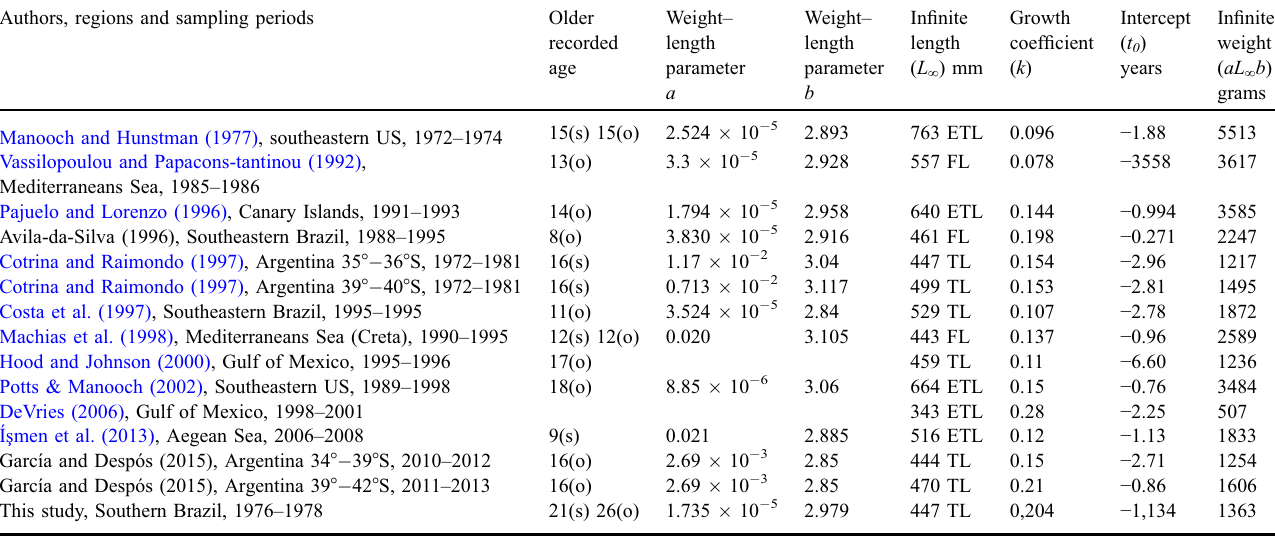
Table 7. Older recorded ages on otoliths (o) and scales (s), parameters of the weight – length relationship and the von Bertalanffy growth equation of Pagrus pagrus estimated in former studies in the southwestern Atlantic Ocean, northern Atlantic Ocean and the Mediterranean Sea in which age determinations were validated. For consistent comparisons, the length-at-age was standardized to the total length, measured from the snout to the tip of the upper limb of the tail in the normal position as used in this study. A factor of 0.97 was applied for the length measured from the snout to the extended caudal fi n and a factor of 1.19 to convert fork lengths recorded.